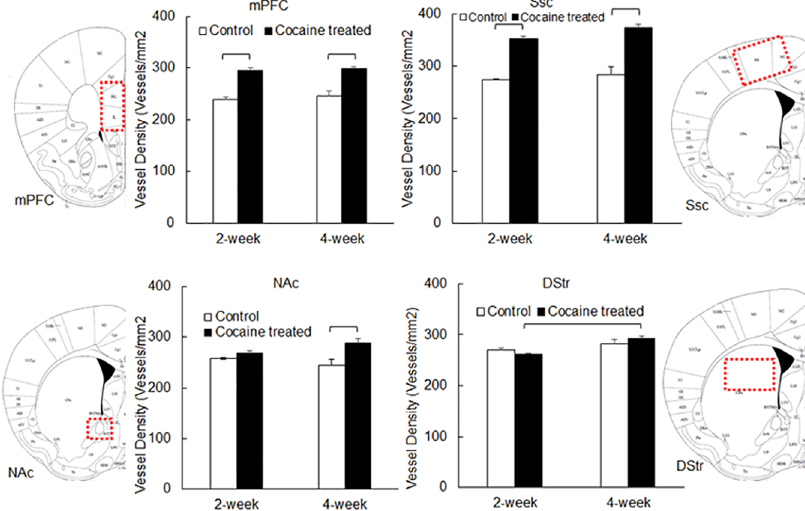
Fig 3. Microvascular density in rat brain tissue measuredusing immunofluorescencemicroscopy. Data is presented as mean + standarderror (n = 3). ANOVA was used to detect significantdifference between treatment groups. All significantdifferences ( P < 0.05)are